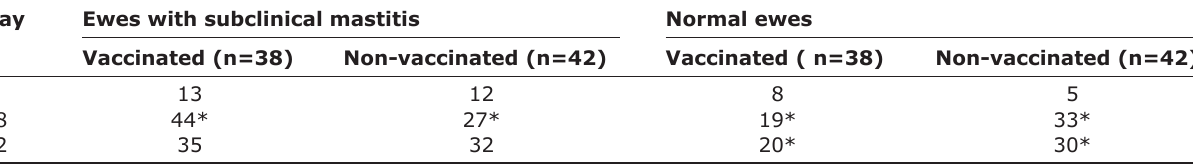
*Between rows indicate